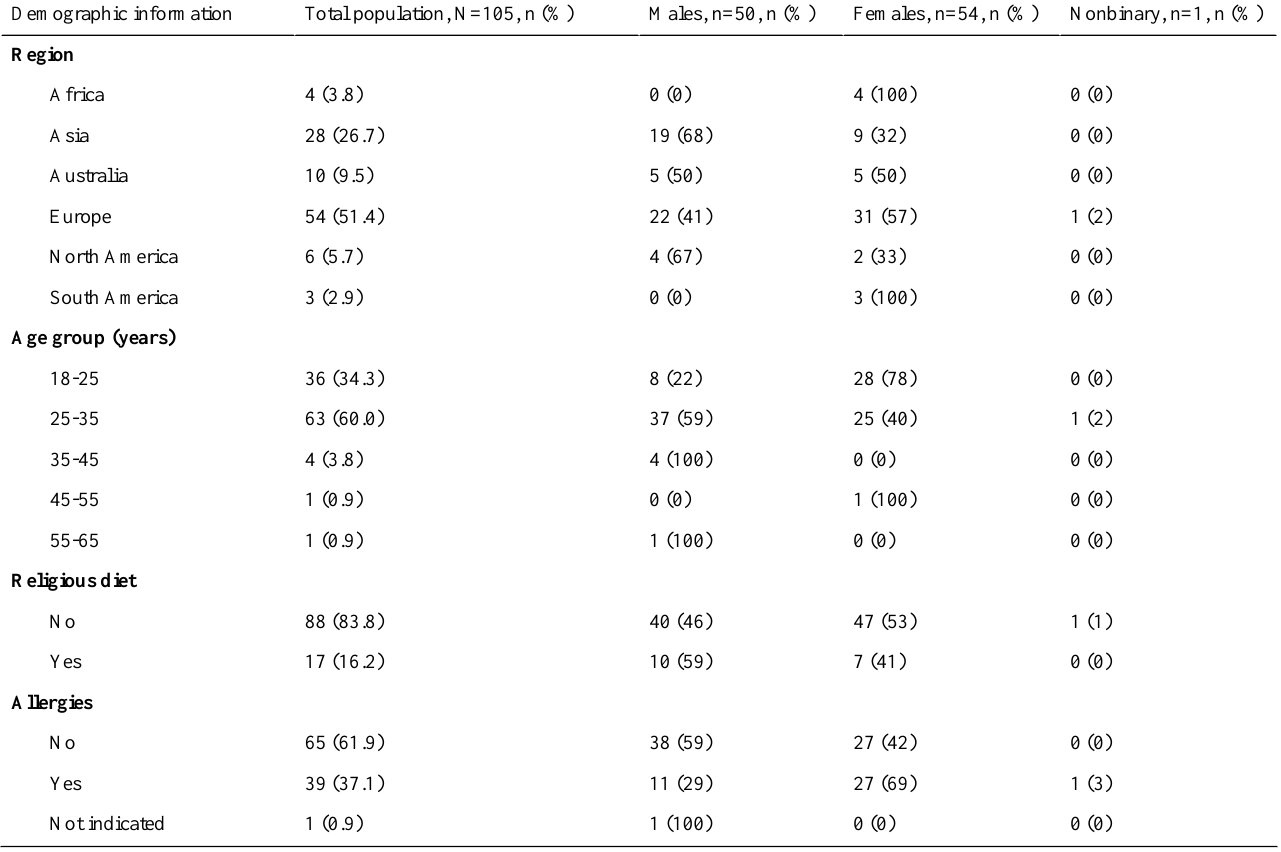
Table 2. Demographic information of the participants